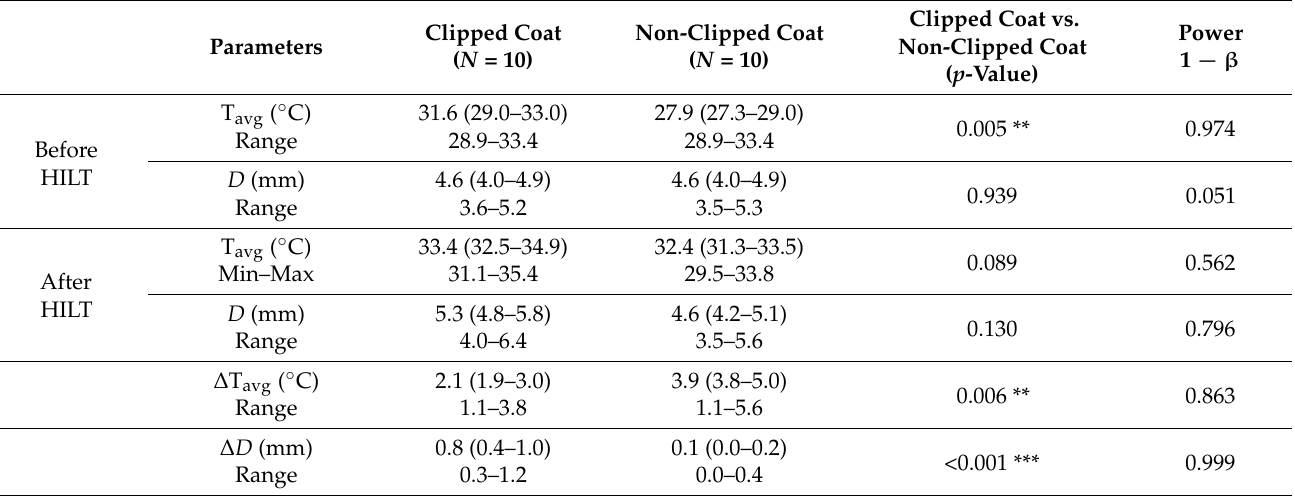
Table 1. Skin surface temperature, vein diameter and differences in skin temperature and vein di- ameter values (median (Q1 – Q3) and range (Min – Max)) before and after high-intensity laser therapy (HILT) application to horses with clipped and non-clipped coats.